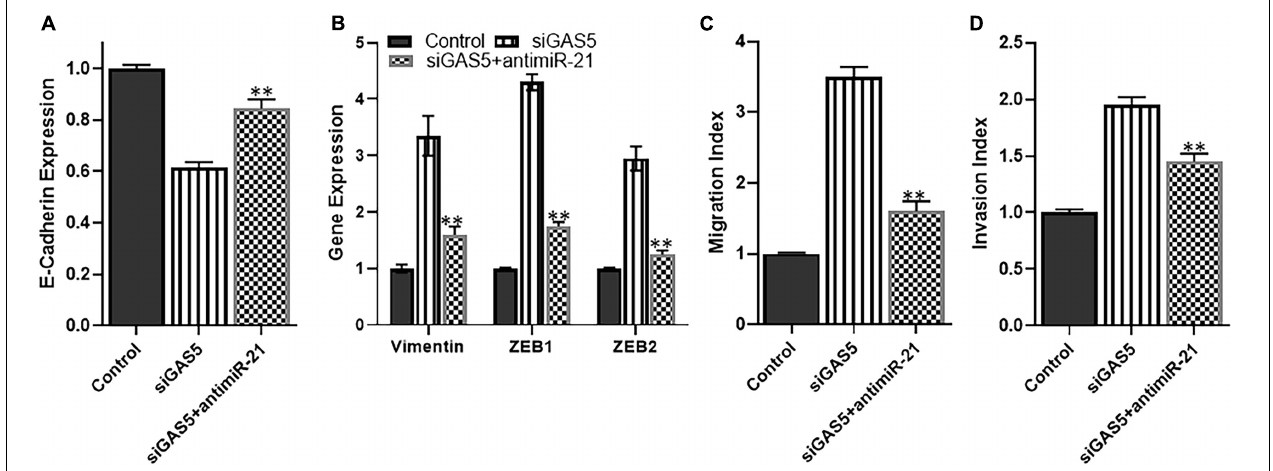
FIGURE 5 | miR-21 reverses growth arrest specific 5 (GAS5)-silencing effects. The effect of microRNA (miRNA) miR-21 to reverse the effects GAS5 silencing was studied in U2OS cells. GAS5 was downregulated by siRNA in U2OS cells, followed by transfections of anti-miR-21. The resulting effects on panel (A) expression of